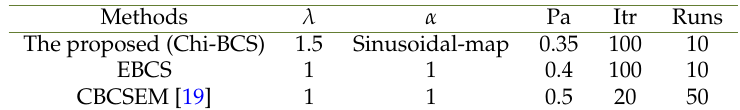
Table 1. Setting parameters for proposed Ch-BCS and previous